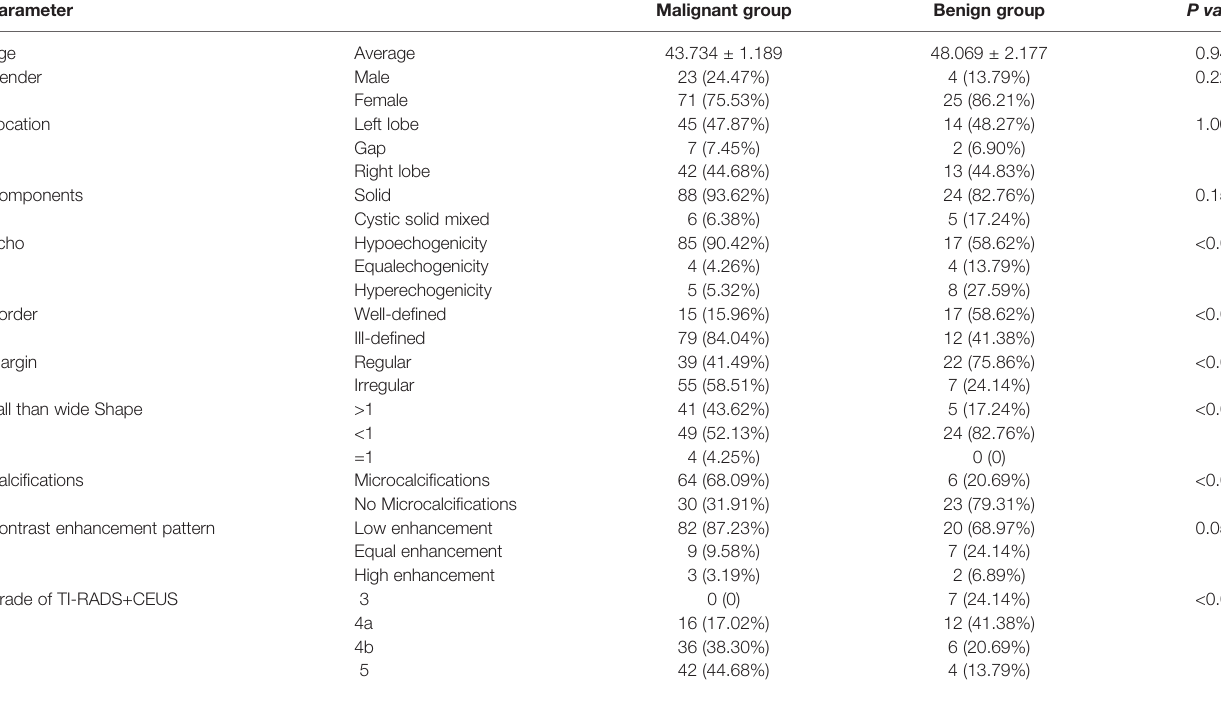
TABLE 1 | Comparison of the general information between the benign and malignant groups.